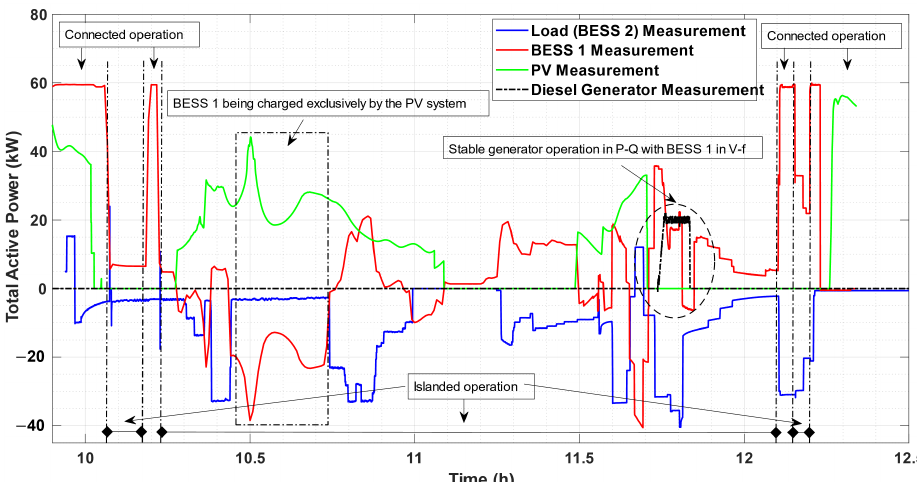
Figure 10. Active power of microgrid components collected by power analyzer.